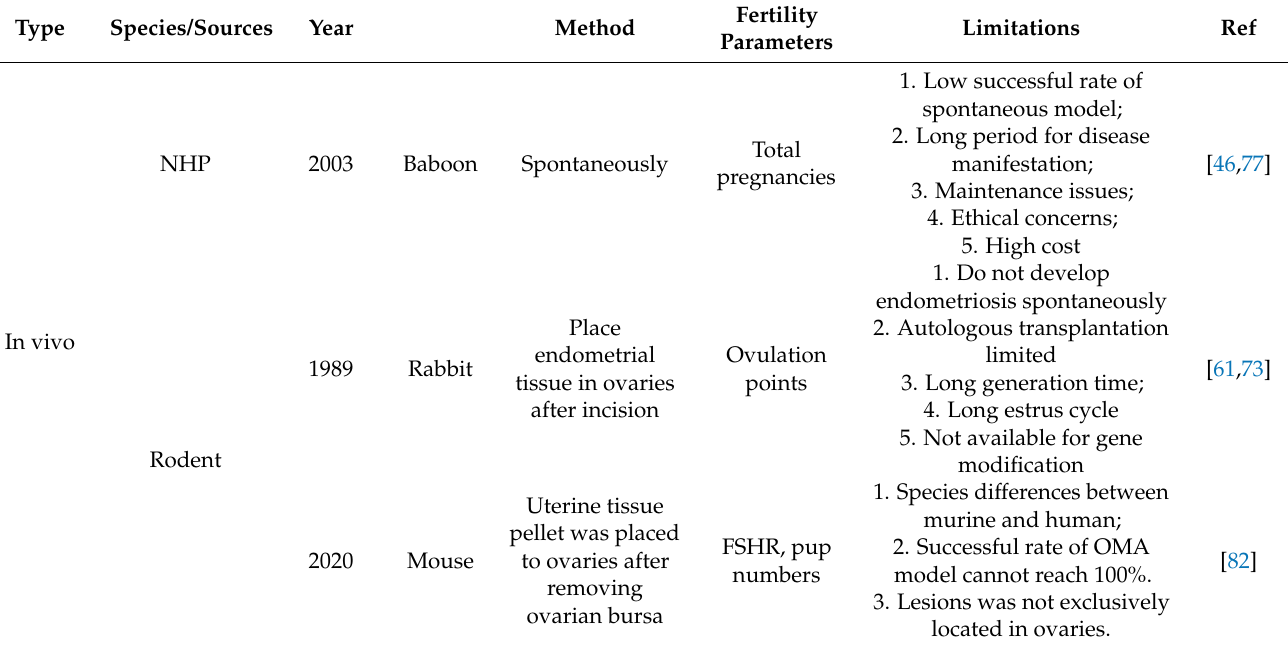
Table 1. OMA-associated infertility models